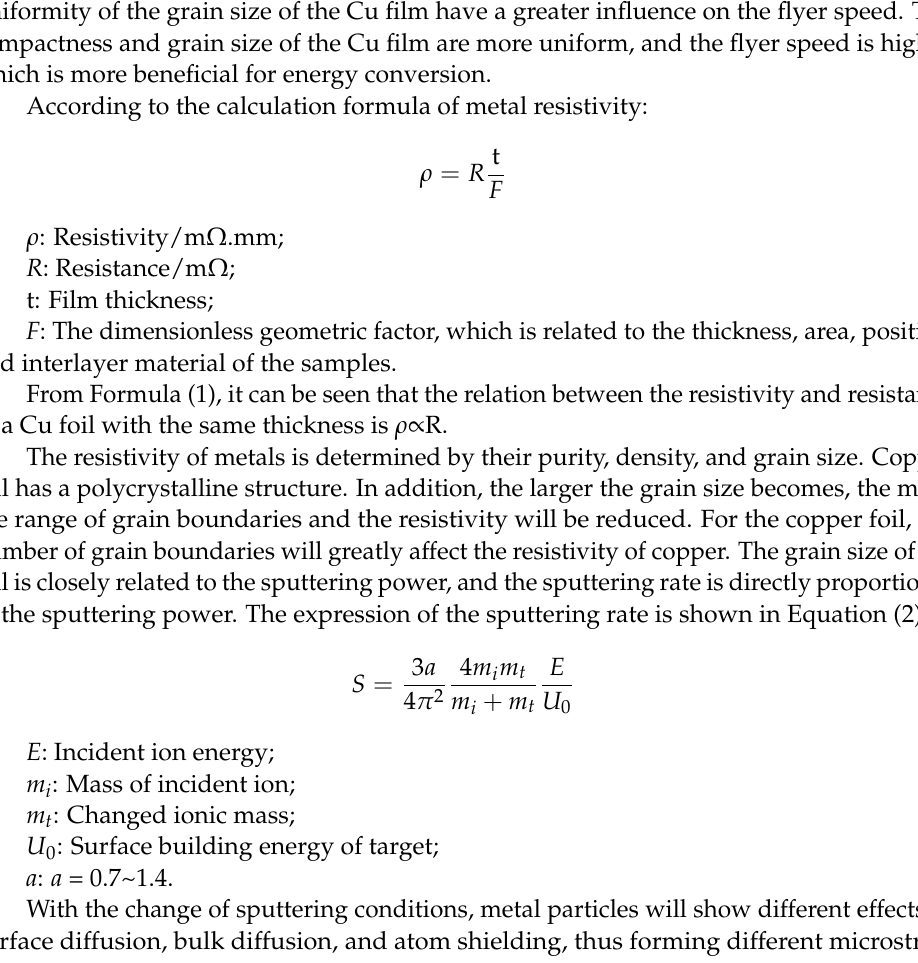
Figure 8. The displacement curves of the flyer velocity for three samples: ( a )1.5 kV and ( b )2.0 kV. It can be seen from Figure 8 that the flyer speed of Sample A is the smallest under the same driving voltage, followed by that of Samples B and C. It can be obtained from the experimental data that, under the same driving voltage, the compactness and the uni- formity of the grain size of the Cu film have a greater influence on the flyer speed. The